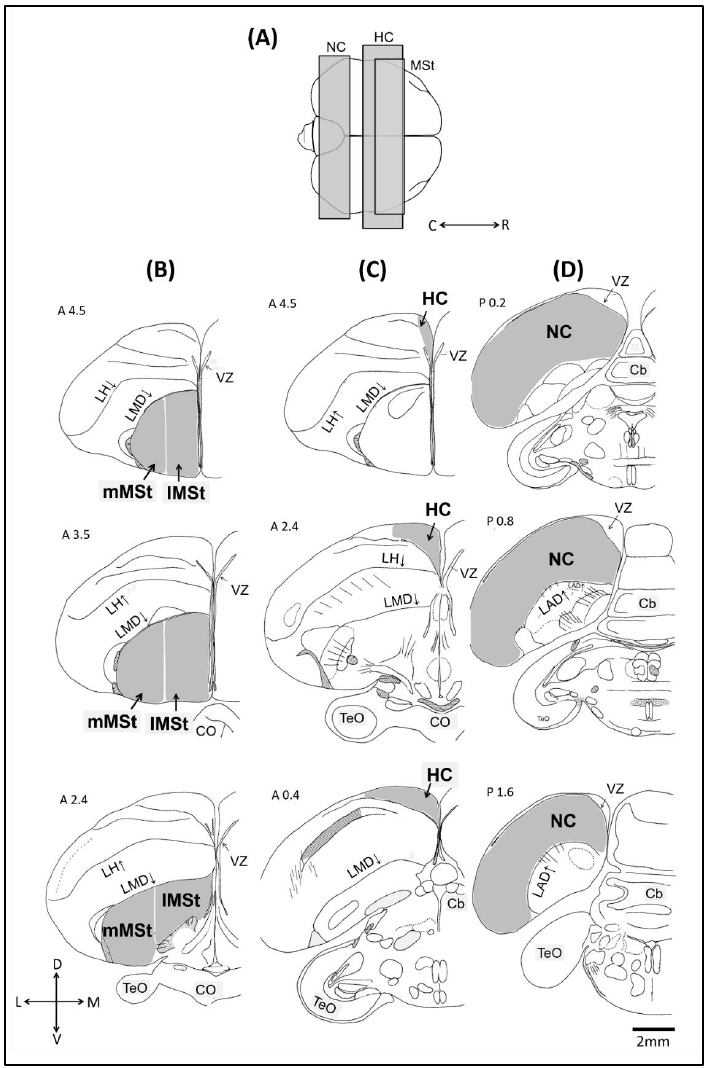
Figure 7. Schematic views of the three investigated brain regions. ( A ) Top view of the brain: rostral is to the right, and caudal is to the left. We indicate the range within which frontal sections were taken from the nidopallium caudale (NC), the hippocampus (HC) and the medial striatum (MSt). Five sections were sampled along the rostrocaudal axis of each brain region. For MSt ( B ), HC ( C ) and HC ( D ) only three are shown: the most rostral, the middle, and the most caudal (from top to bottom). Abbreviations: Cerebellum (Cb), Lamina arcopallialis dorsalis (LAD), Lateral ventricle (V), Tectum opticum (TeO). Orientations: Dorsal (D), Lateral (L), Ventral (V), and Medial